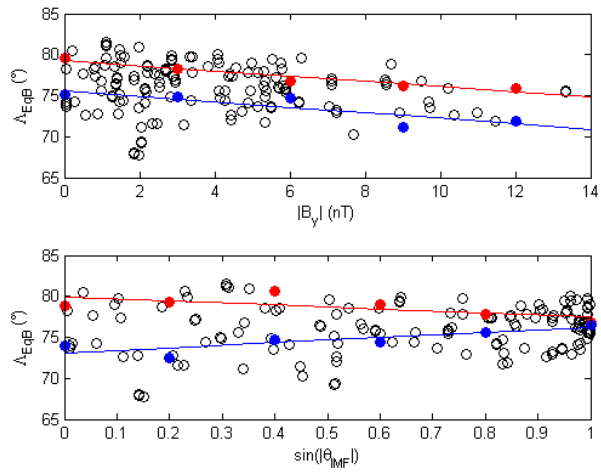
Fig. 18. Invariant latitude of the cusp equatorward boundary versus | B y | (top) and sin | θ IMF | (bottom). In red and blue are the binned mean invariant latitudes and the corresponding linear fit for north- ward and southward IMF, respectively. Only crossings under steady IMF are